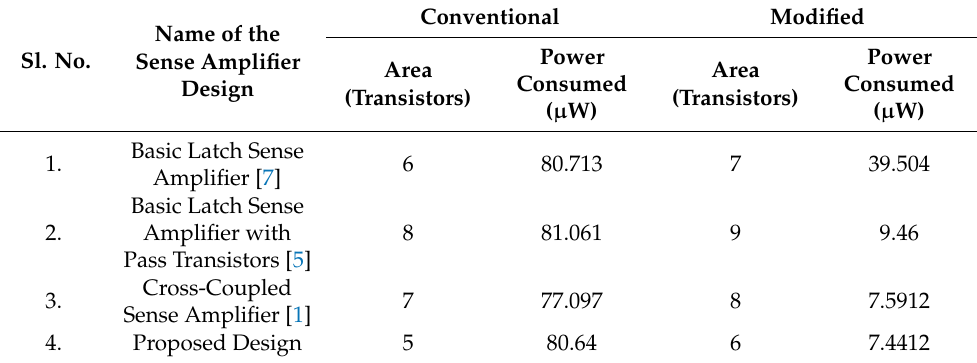
Table 3. Comparison of average power consumption for all the designs with their modified versions.